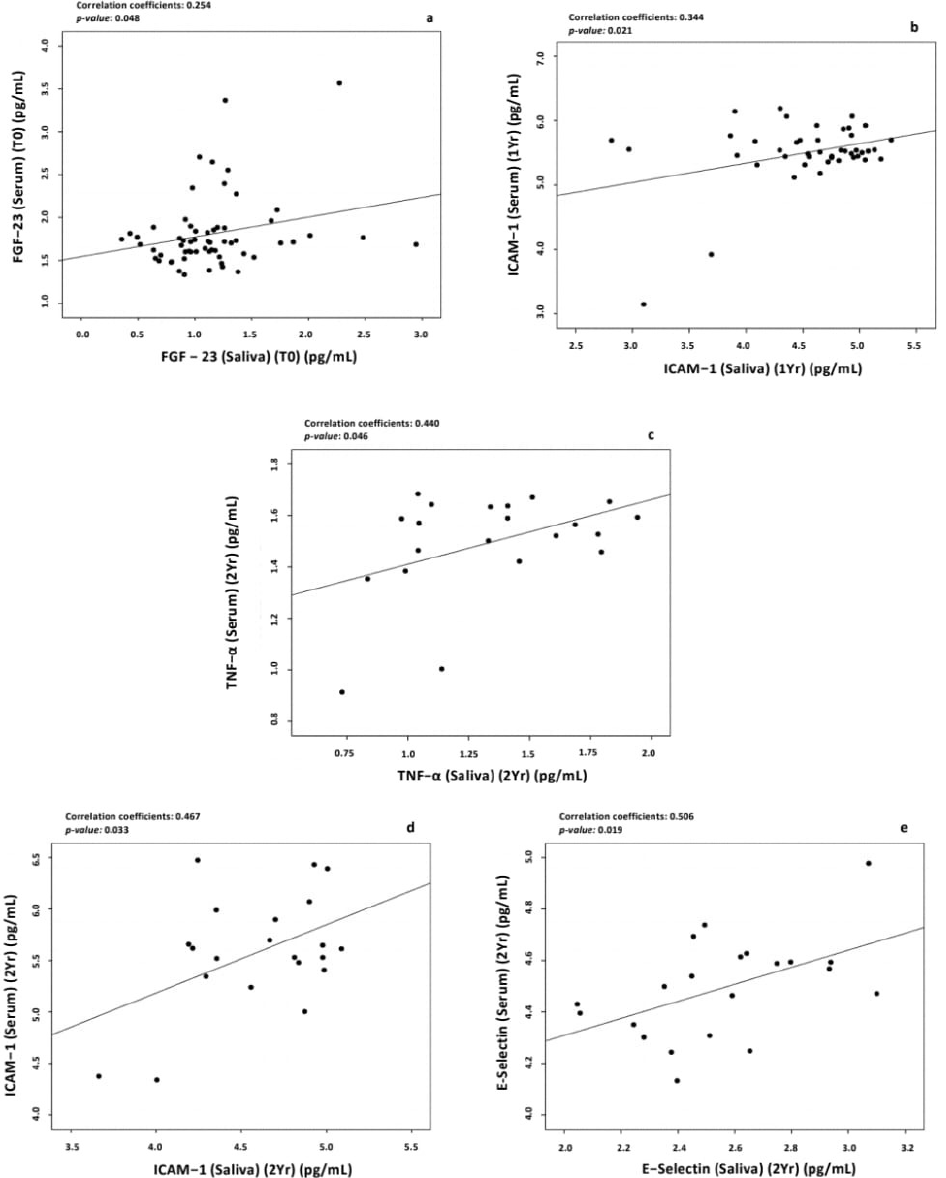
Figure 3. Correlation plot between salivary and serum levels of inflammatory markers: ( a ) Correlation between levels of FGF-23 at baseline; ( b ) Correlation between levels of ICAM-1 at 1-year post- treatment follow-up; ( c ) Correlation between levels of TNF-α at 2-year post-treatment follow-up; ( d ) Correlation between levels of ICAM-1 at 2-year post-treatment follow-up; ( e ) Correlation between levels of E-selectin at 2-year post-treatment follow-up.